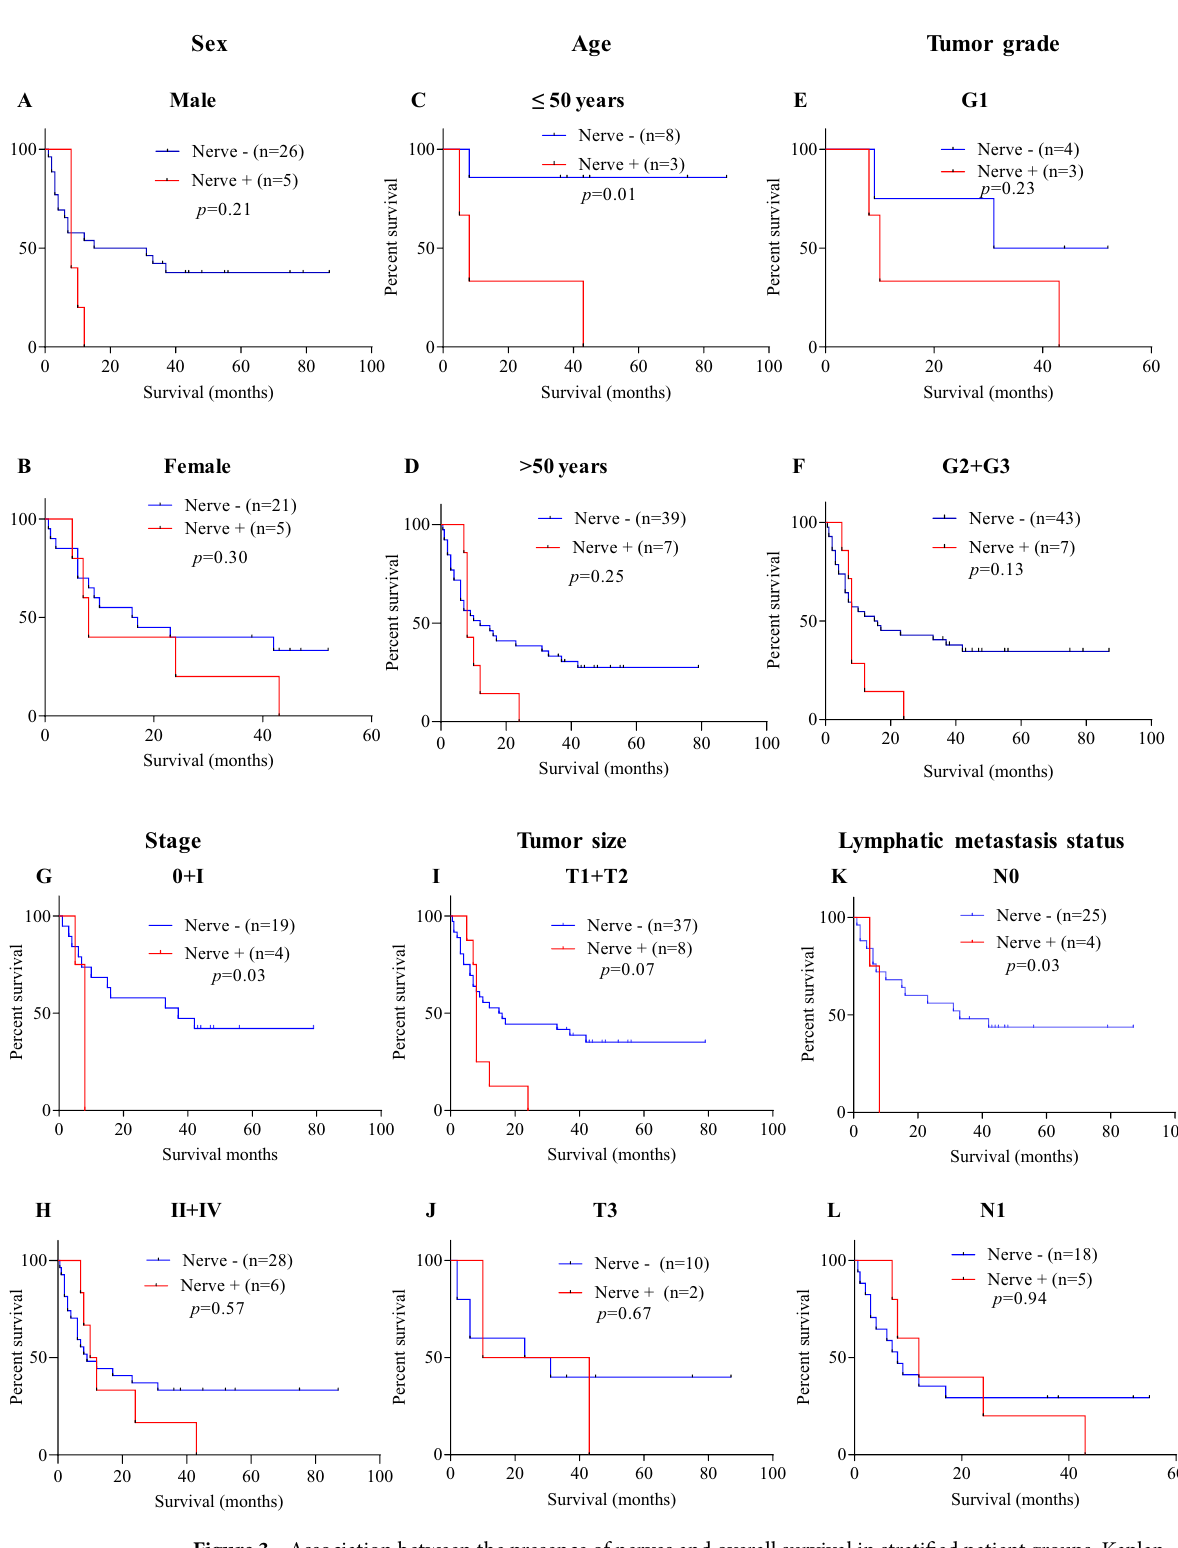
Figure 3. Association between the presence of nerves and overall survival in stratified patient groups. Kaplan– Meier survival curve comparing cases positive versus negative for nerve infiltration after patient stratification in function of sex ( A , B ), age ( C , D ), tumor grade ( E , F ), stage ( G , H ), tumor size ( I , J ) and lymphatic metastasis status ( K , L ). The results of multiple comparative analyses are presented in the Table